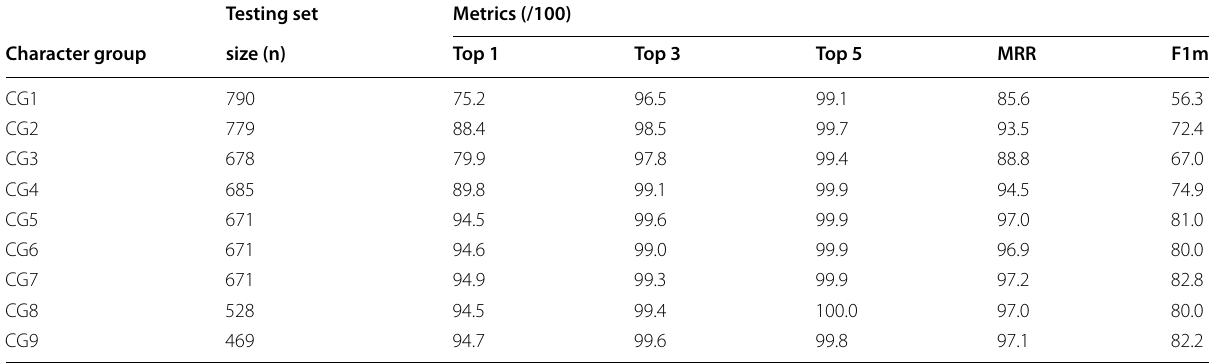
Table 4 Section identification for the same set of characters groups. The hyperparameters were the same as in Table 3 Testing set